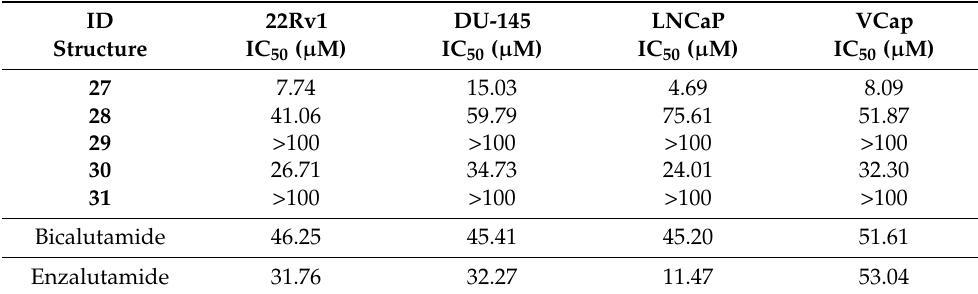
Table 4. In vitro antiproliferative activity of bicalutamide analogues ( 27 – 31 ) across four human prostate cancer cell lines (DU-145, 22Rv, LNCaP, and VCap). All data are mean values from experiments carried out on three separate occasions.